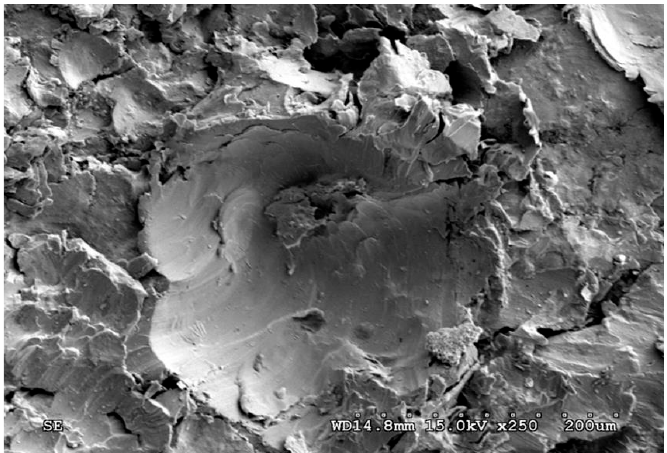
Figure 3. Surface of ADI_310_SP after shot peening (SEM).